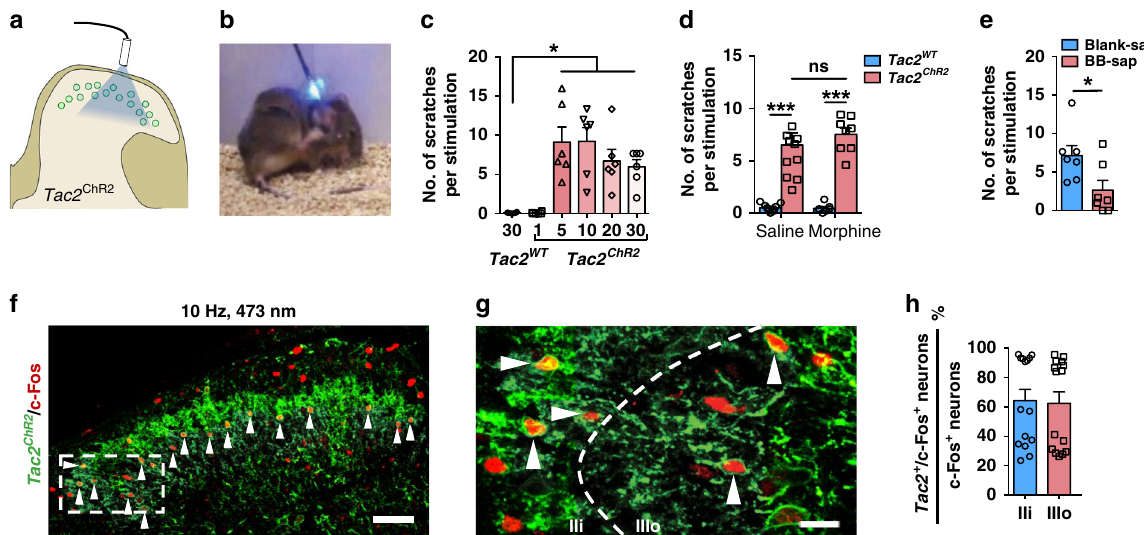
Fig. 3 Optostimulation of Tac2 neurons evoked itch-related scratching behavior. a Schematic of blue light stimulation of Tac2 ChR2 neurons. b , c A snapshot ( b ) and quanti fi cation ( c ) of blue light-induced scratching behaviors in Tac2 ChR2 mice. One-way ANOVA with Tukey post - hoc , * p = 0.012. n = 6 mice per group. d The effect of i.t. morphine on blue light-induced scratches. Two-way ANOVA with Bonferroni post-hoc , *** p = 0.00001, n = 9 for Tac2 WT /saline, n = 7 for Tac2 WT /morphine, n = 11 for Tac2 ChR2 /saline, n = 8 for Tac2 ChR2 /morphine. e Blue light-induced scratches decreased after BB-sap treatment. Two-tailed Student ’ s unpaired t- test, * p = 0.029, n = 7 mice per group. f Double IHC of c-Fos (red) and GFP (green) in the spinal cord of Tac2 ChR2 mice following blue light stimulation. g Higher magni fi cation of the boxed area in f . Arrowheads indicate double-stained c-Fos + / Tac2 ChR2 + neurons in f , g . Scale bars, 50 μ m in f and 10 μ m in g . h Quanti fi cation of percentages of Tac2 ChR2 /c-Fos double positive neurons in c-Fos positive neurons in laminae IIi and IIIo, respectively. n = 3 mice. All data are presented as means ± s.e.m. and error bars represent s.e.m. Source data are provided as a Source Data fi